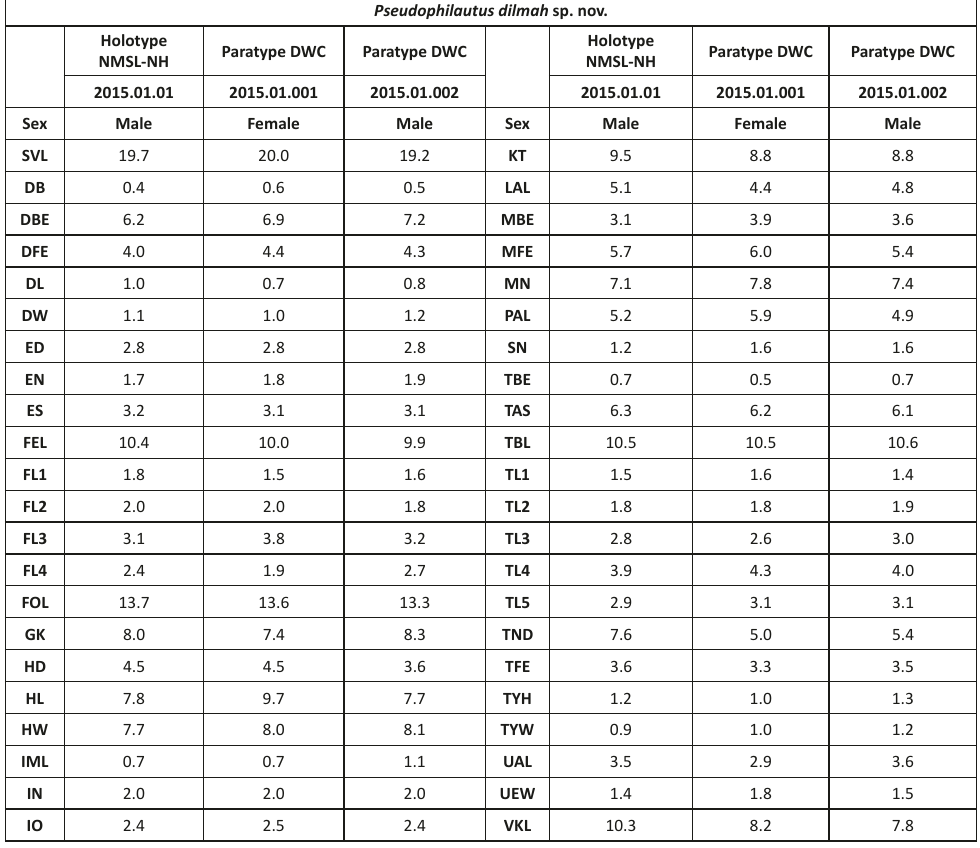
Table 1. The morphometric measurements (mm) of the type series of Pseudophilautus dilmah sp. nov.